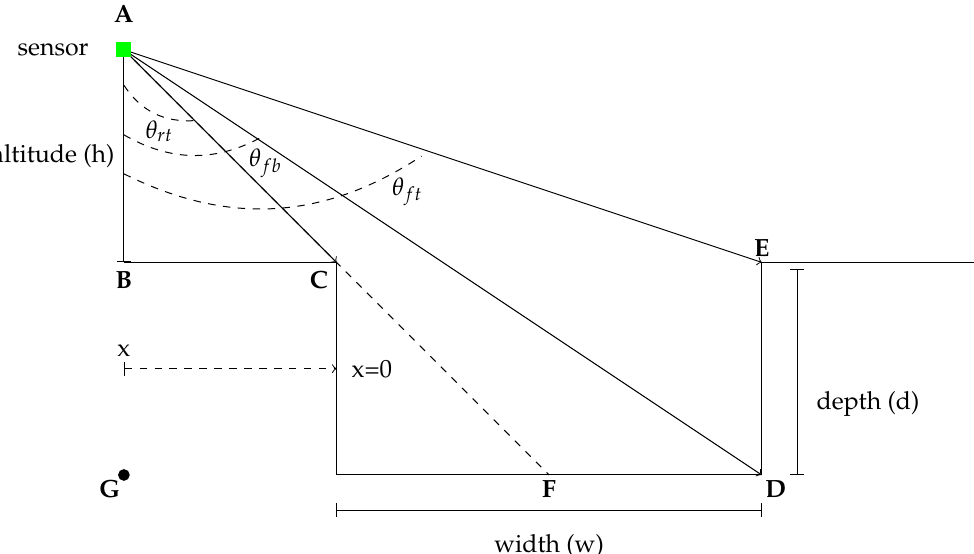
Figure 1. Side view of the ground coverage metric calculation. Points A , B , C , D , E , F , and G are defined to aid the reader in following the derivations of Equations